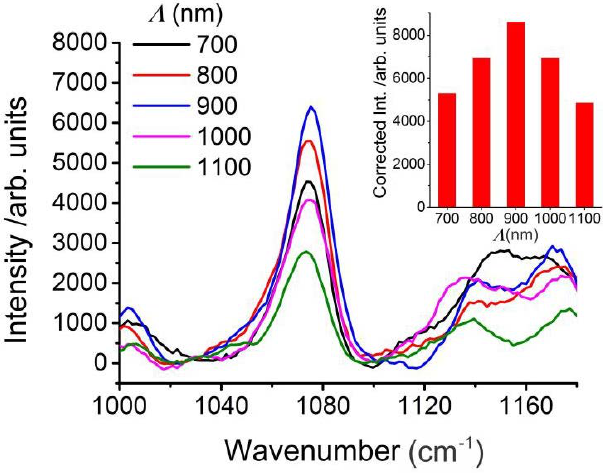
Figure 9: SERS spectra of para-mercaptoaniline (pMA) obtained on the optoplasmonic arrays with Λ = 700 – 1100 nm. The inset shows filling fraction-corrected peak SERS signal intensities as a function of Λ . Reprinted with permission from Hong et al. Adv. Funct. Mater. 24, 739 (2014). Copyright 2013 Wiley-VCH GmbH & Co.